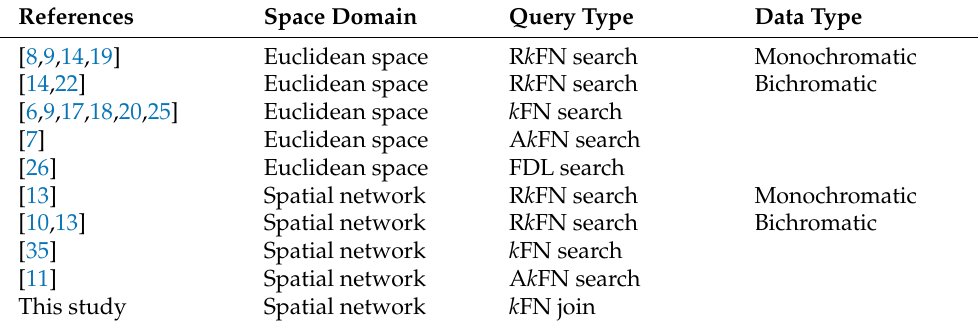
Table 1. Classification of related work.